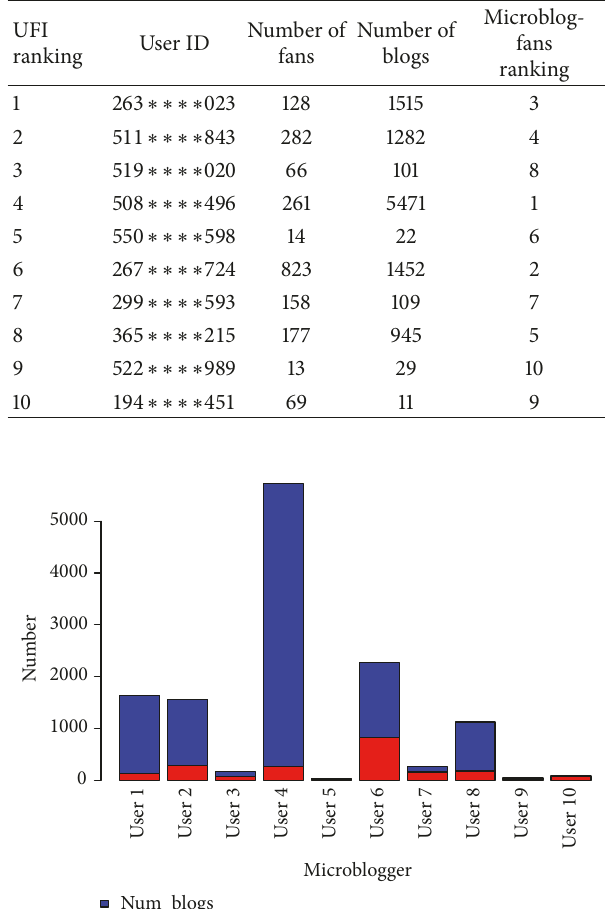
Table 9: Comparison of UFI method with microblog-fans ranking algorithm.